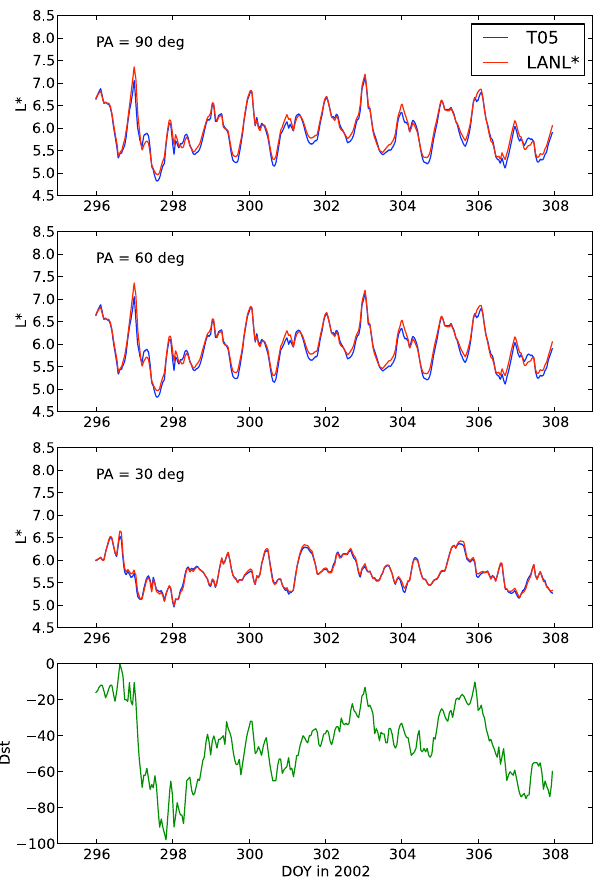
Fig. 6. Calculating the L ∗ time series during a moderate storm with Dst= − 100nT following the ephemerides of LANL geosyn- chronous satellite 1990-095. The geomagnetic storm had its Dst minimum close to 25 October 2002 (DOY=298). The L ∗ values from the underlying TS05 model (blue) and from the LANL ∗ neu- ral network (red) are compared for 90, 60, 30 ◦ pitch angles. The bottom panel shows the disturbance storm time index (Dst) for this period.